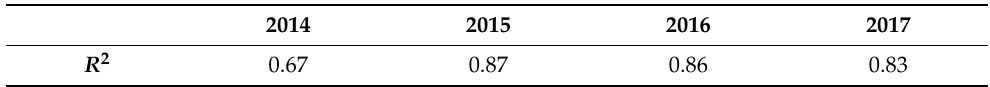
Table 5. R 2 of the multivariate regression of actual evapotranspiration against the linear combination of the considered drivers using all growing seasons without inter-annual distinctions. (All regressions are significant at 95% confidence level).